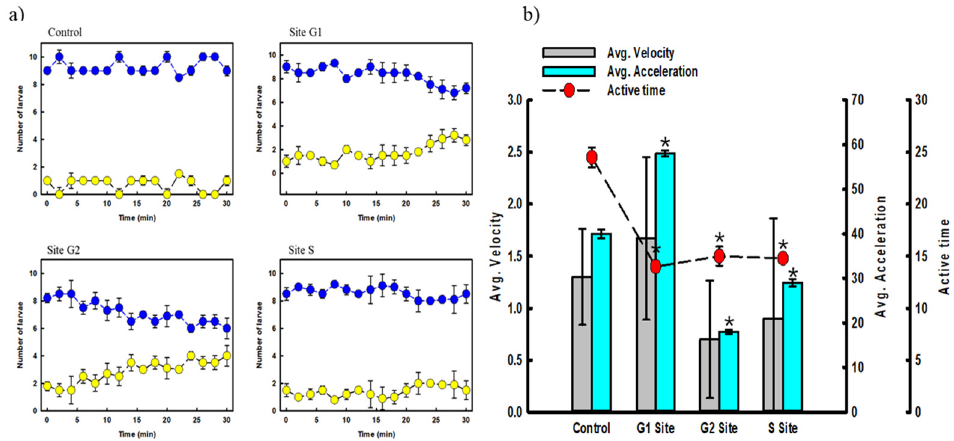
Figure 5. ( a ) Cognitive function, and ( b ) locomotion changes of zebrafish larvae (Real-site sample) (blue; preferred region, yellow; non-preferred region, * p < 0.05).